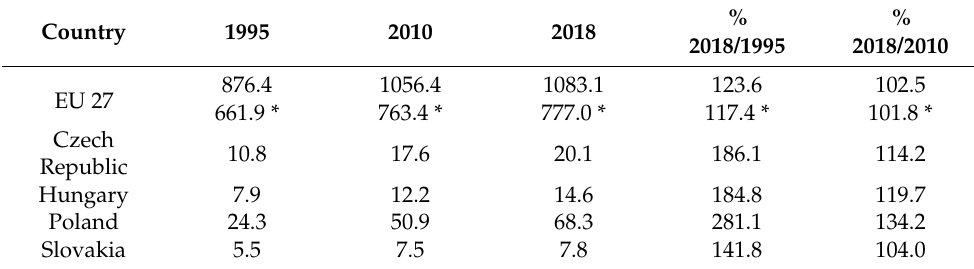
Table 1. CO 2 emissions by transport in the V4 and EU